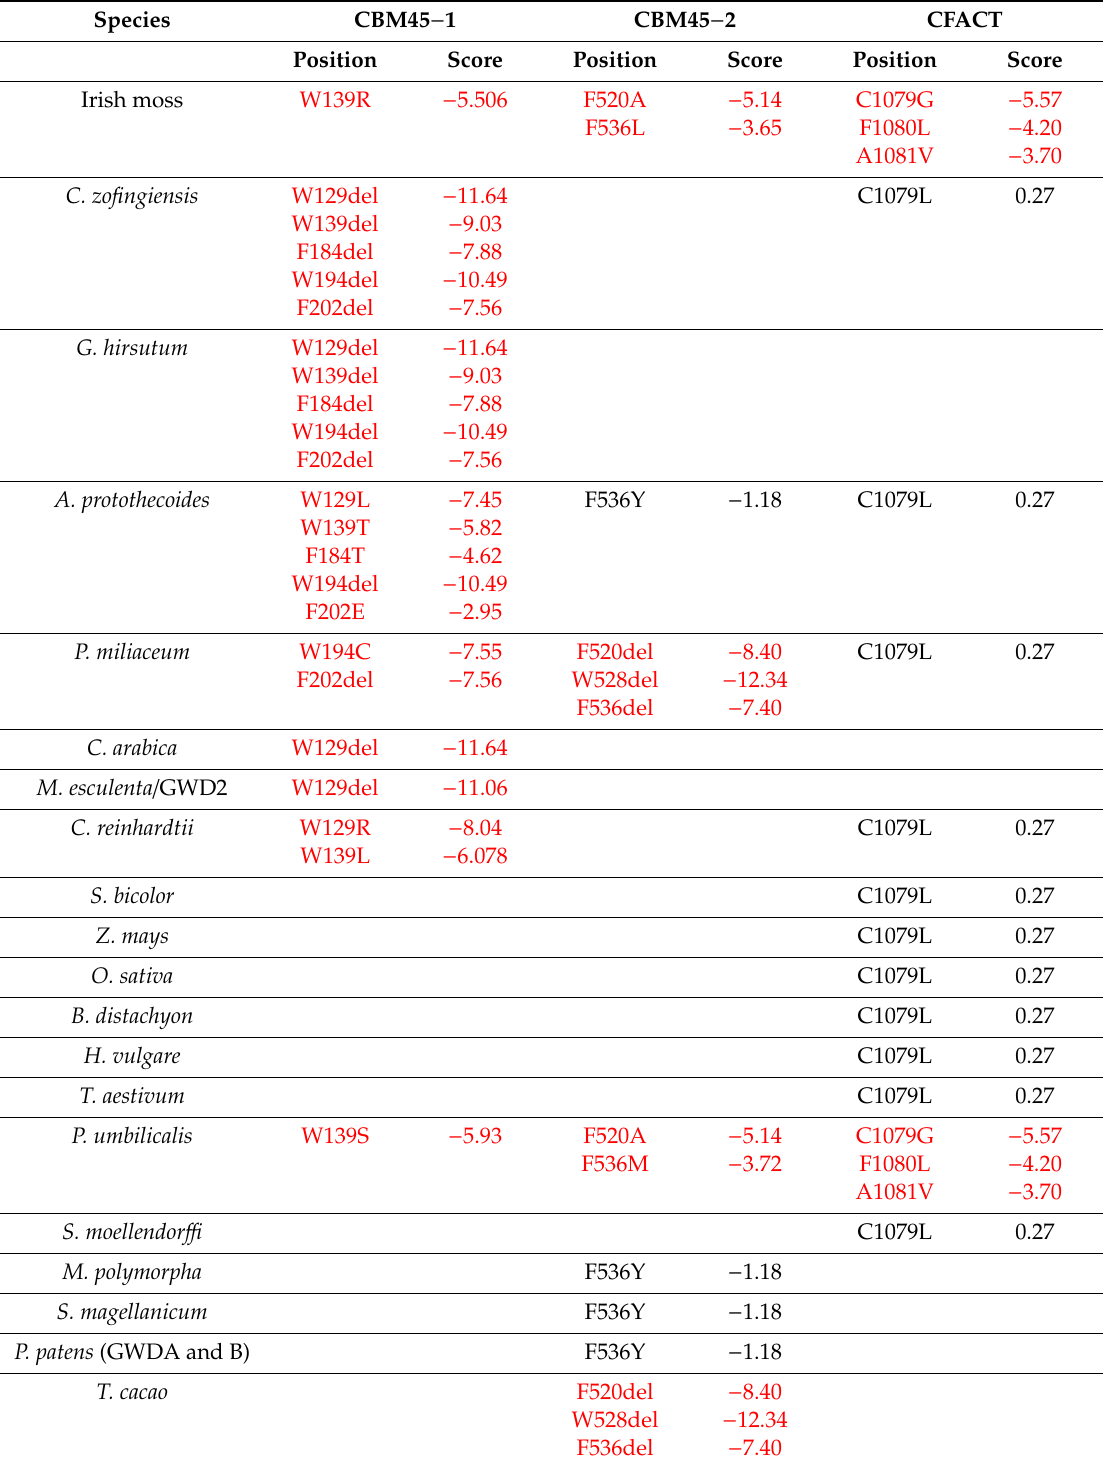
Table 3. Prediction of mutational e ff ects on GWD of selected